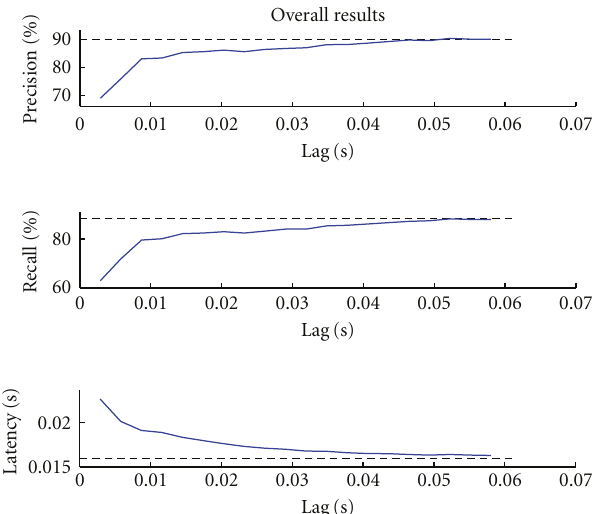
Figure 5: Overall results for the two percussion instruments. The dashed line indicates o ffl ine performance. The curves show how the performance depends on the amount of lag used in the HMM procedure. The overall input-output latency of the method is determined by the sum of lag and latency in the bottom